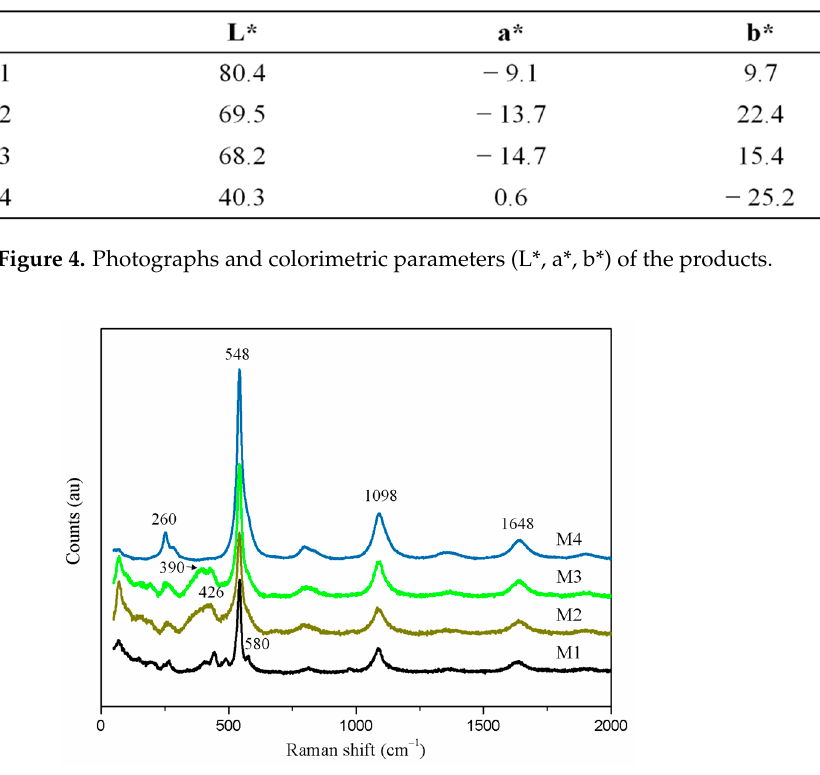
Figure 5. Raman spectra of product M1, M2, M3, and M4.